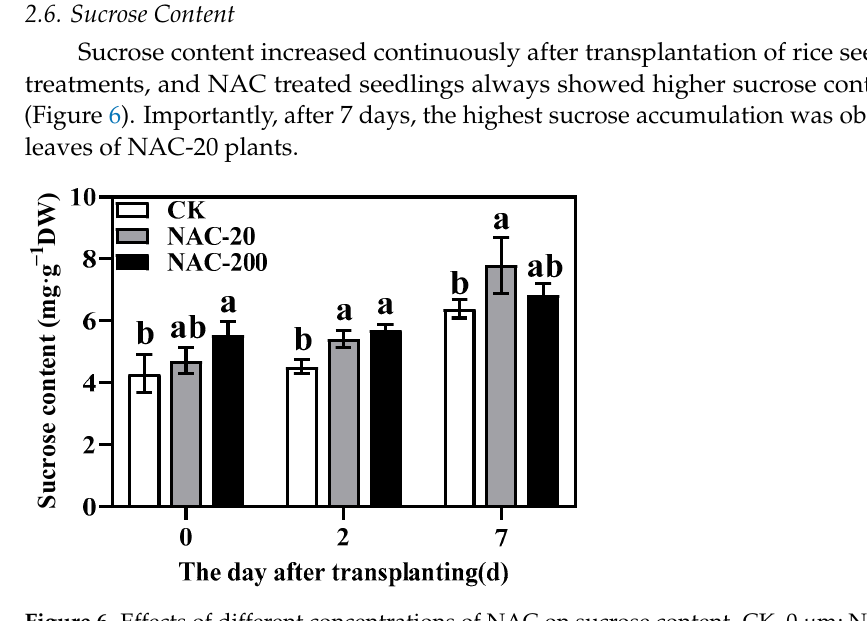
Figure 5. Effects of different concentrations of NAC on Pn ( A ), Tr ( B ), Ci ( C ), and Gs ( D ). CK, 0 µ m; NAC-20, 20 µ m; NAC-200, 200 µ m. Data are means ± SD ( n = 3). The different letters following average values indicate significant difference (Duncan, p < 0.05).